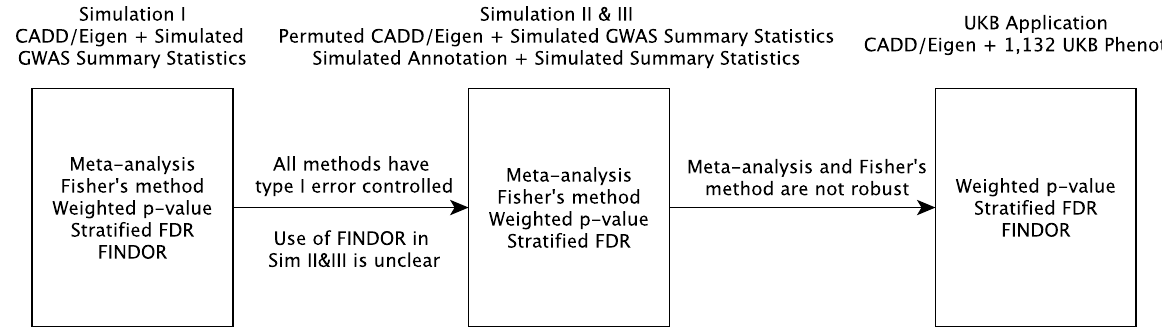
Figure 1. A visual summary of evaluating different methods across the simulation and application study